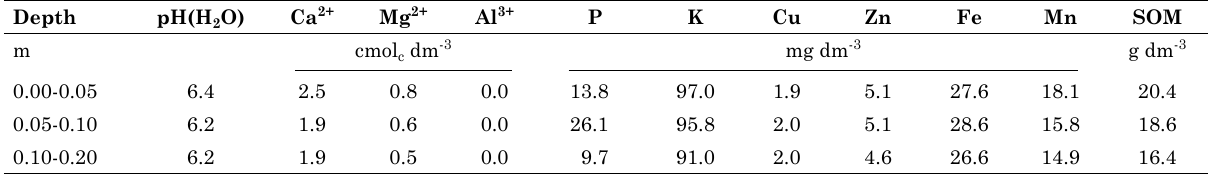
table 1. basic chemical properties of the soil in the experimental area